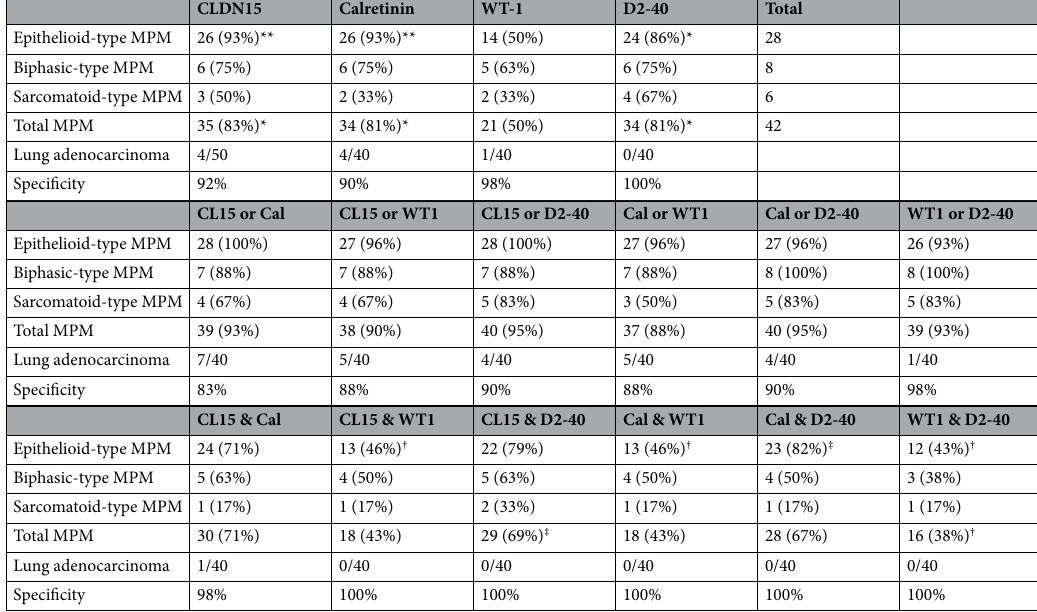
Table 2. Expression of CLDN15 and other markers for MPM in three types of MPMs and lung adenocarcinoma tissues. * p < 0.05; ** p < 0.005 higher than the sensitivity of WT-1; † p < 0.05 lower than CL15&Cal; ‡ p < 0.05 higher than WT1&D2-40. Other pairs were not significantly different.